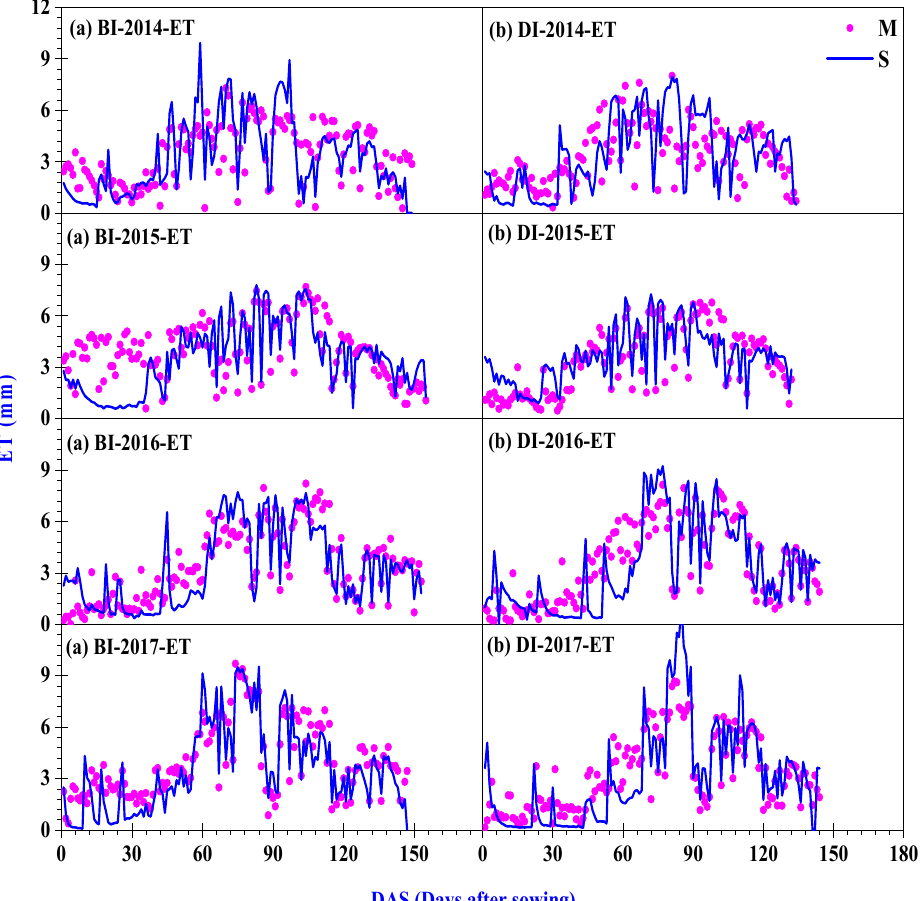
Figure 2. Comparison of measured values (M) and simulated values (S) of evapotranspiration (ET) under border-irrigated (BI) treatment and drip-irrigated (DI) treatment during 2014–2017, respectively.